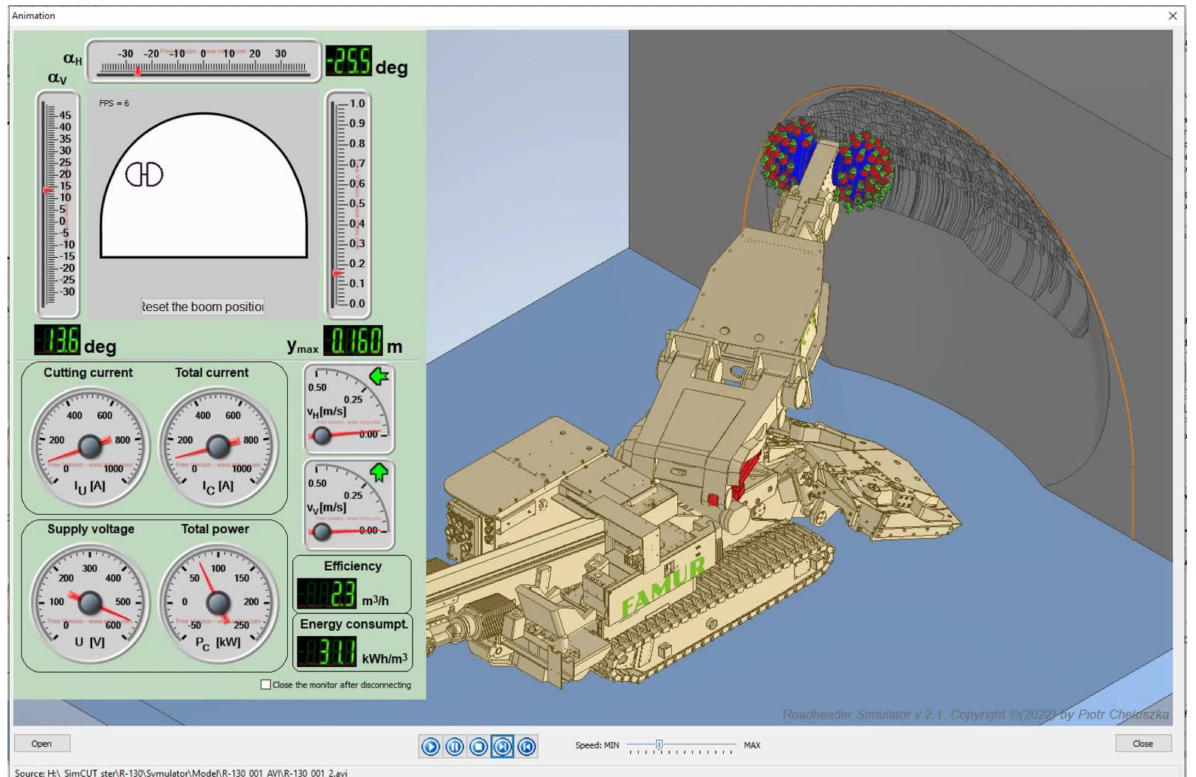
Figure 14. The “Animation” window of the RH-Sim _simulator which enables the playback of the recorded sequence of mining with a